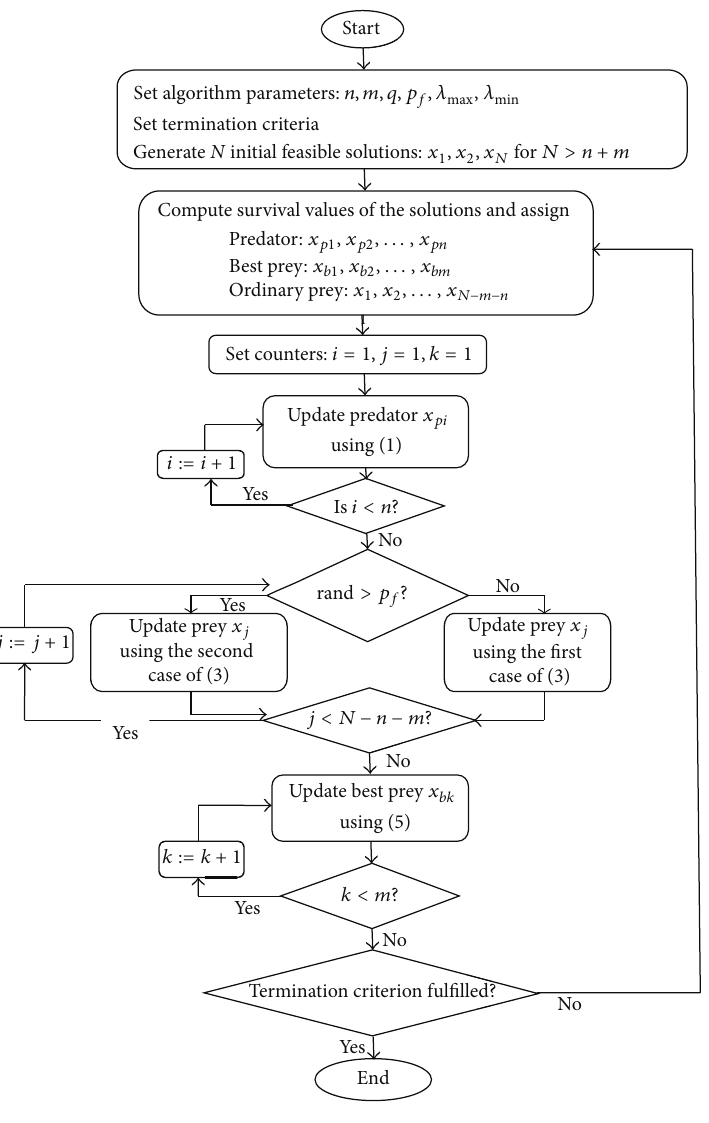
Figure 1: The enhanced prey-predator algorithm ( 𝑛𝑚